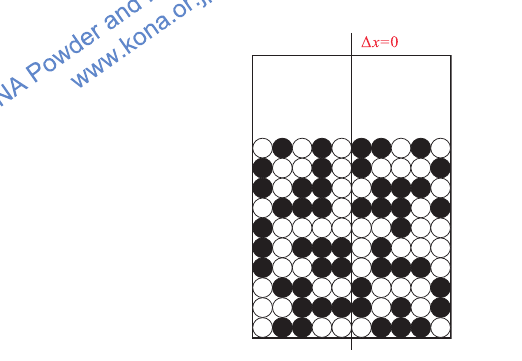
Fig. 2 Schematic representation of the fully-mixed particle state.